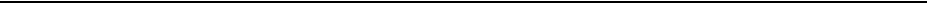
KO-miR-127-3p inhibited autophagy and improved neurological impairment through upregulating the expression of CISD1 in vivo natal rats treated with KO-miR-127-3p to detect the